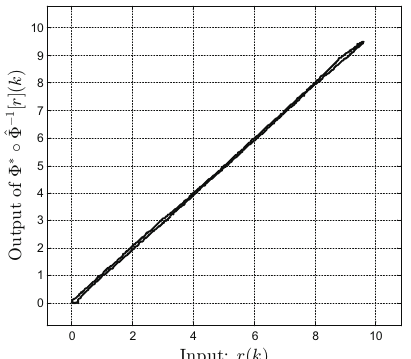
Figure 6. Relationship between the input r ( k ) and the output of the inverse compensation Φ ∗ ◦ ˆ Φ − 1 [ r ]( k )